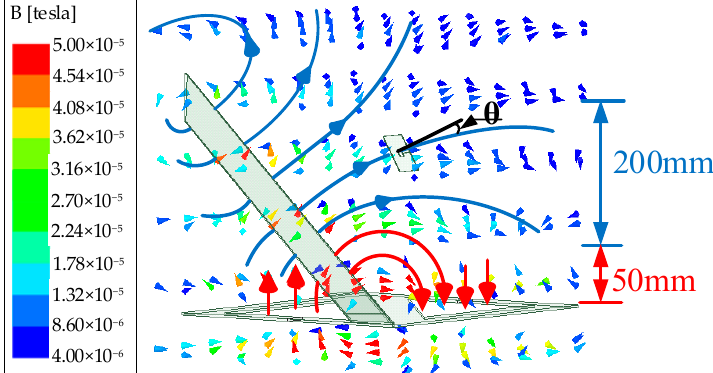
Figure 3. Simulated magnetic field distribution of the 3D Tx coil.